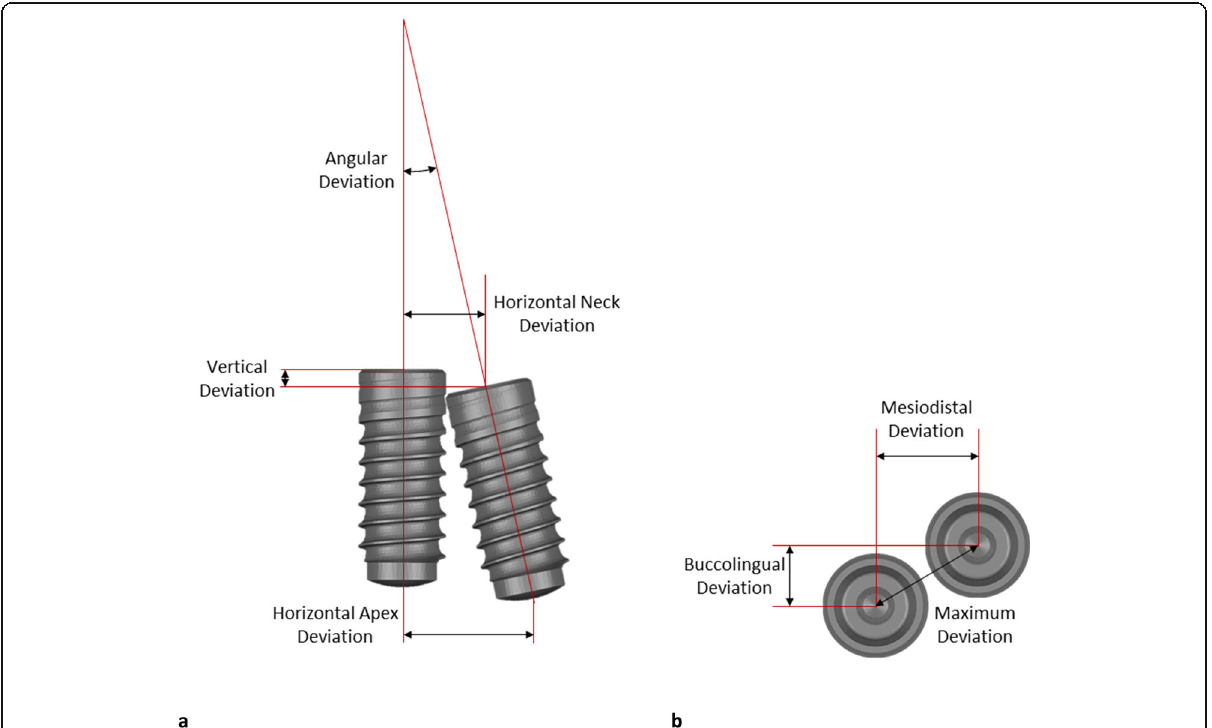
Fig. 2 a Schematic diagram illustrating the measurement of vertical, horizontal neck, horizontal apex, and angle deviations. b Three forms of horizontal deviation were measured: maximum, mesiodistal, and buccolingual